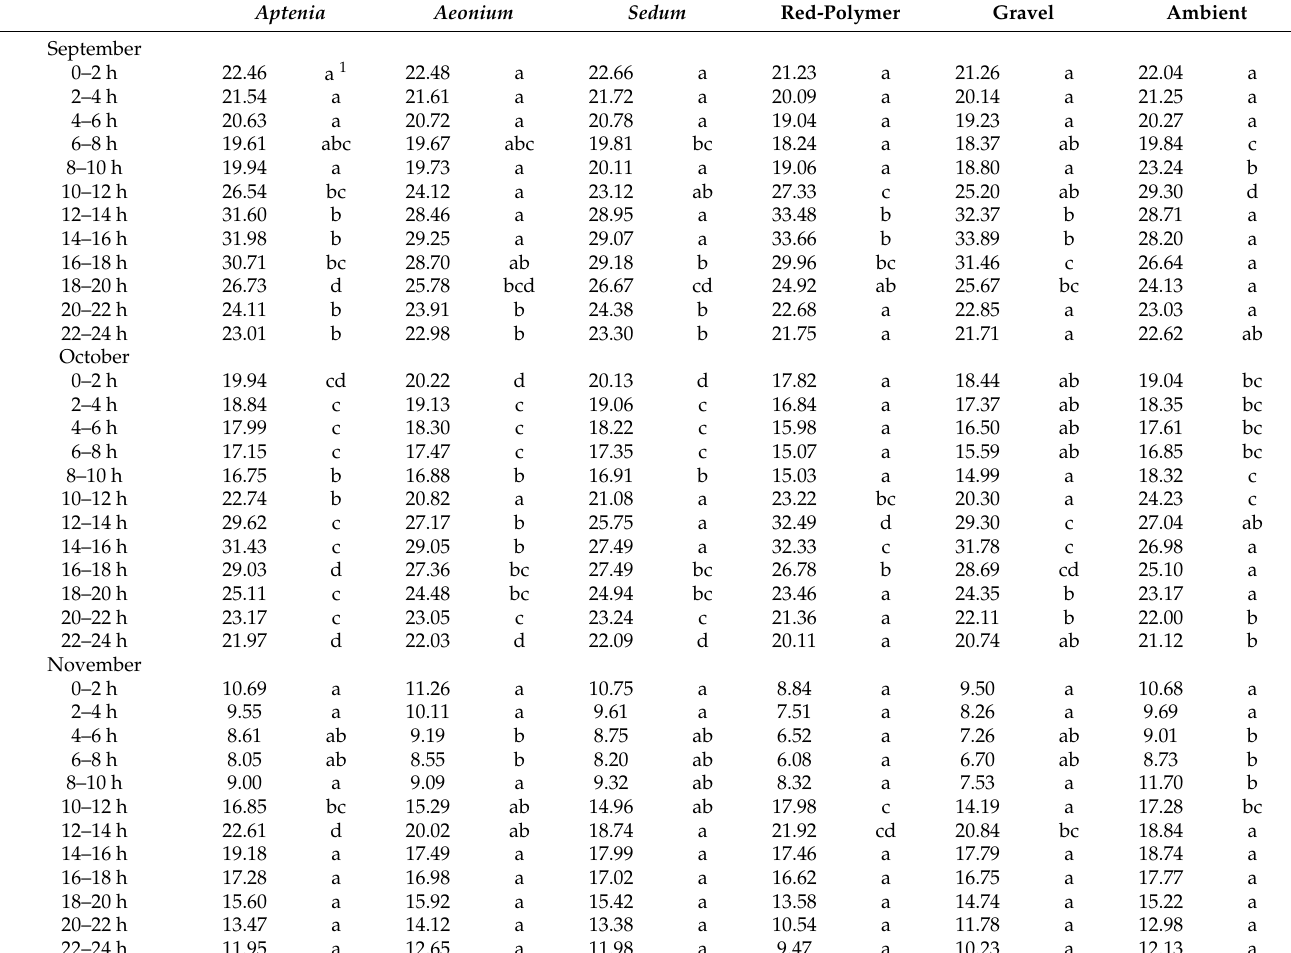
Table 2. Average temperatures ( ◦ C) every 2 h-periods during the day ( n = 5 days) in